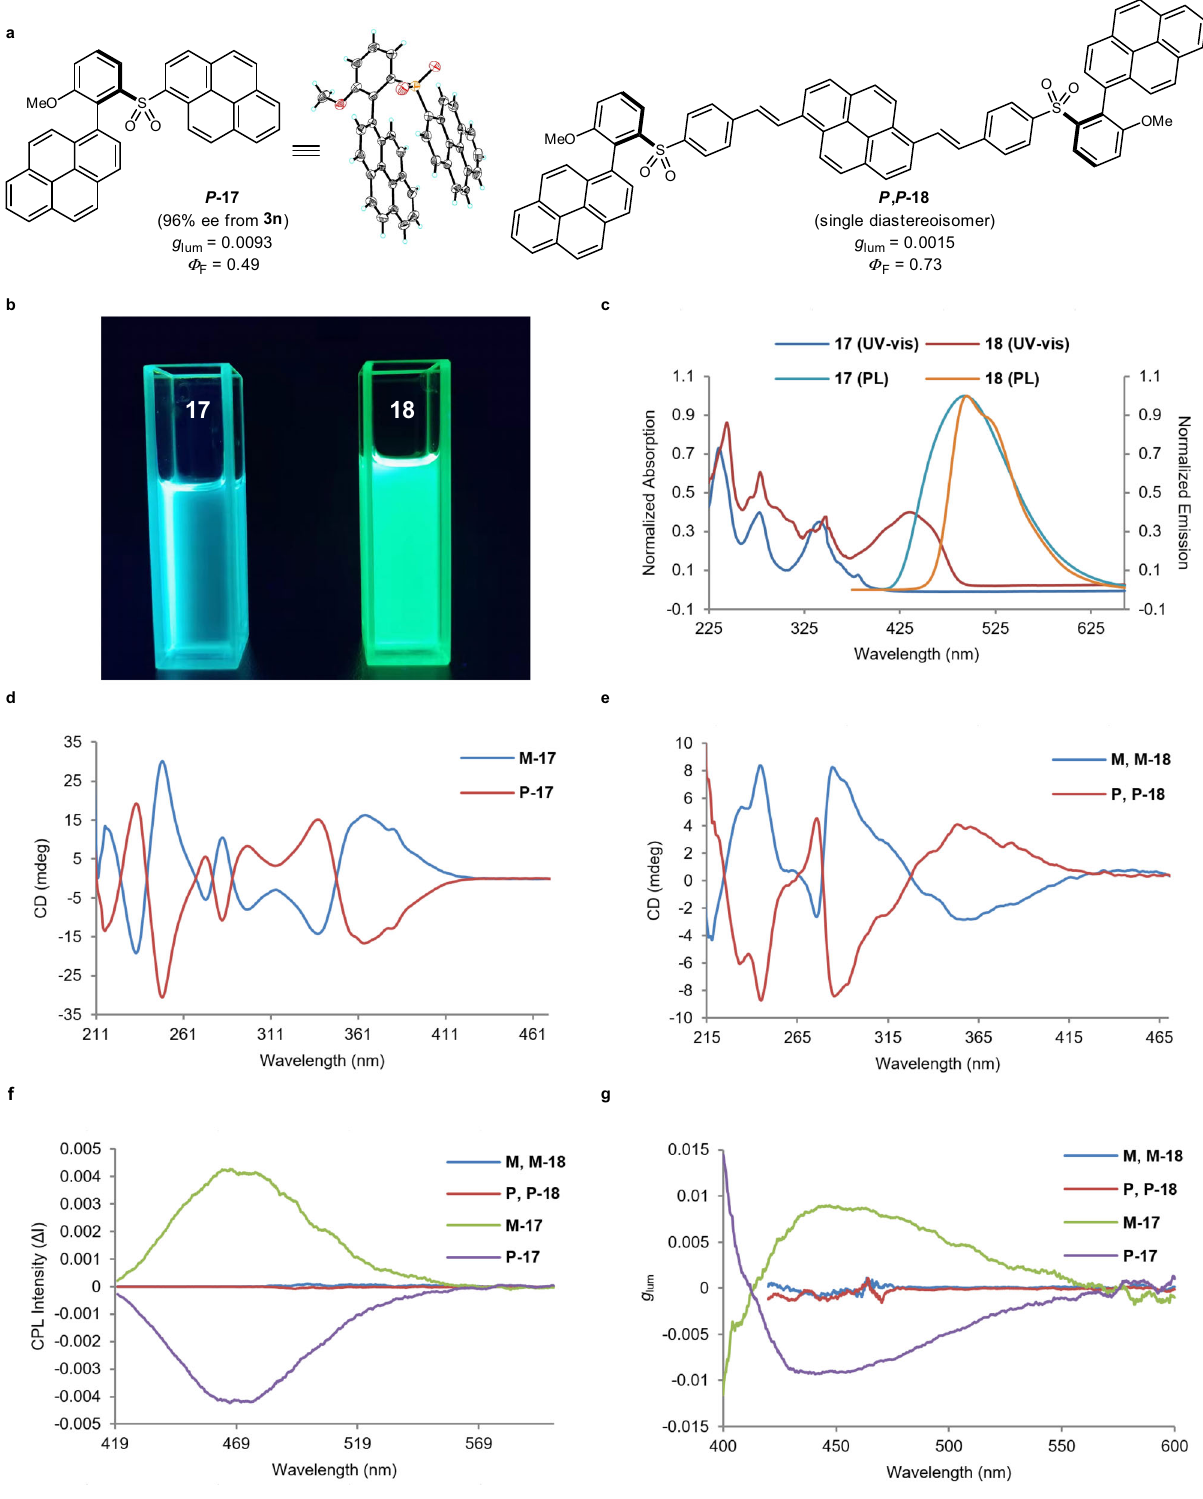
Fig. 7 | Photophysicalproperties of chiralcompounds 17 and 18.a Structures of 17 and 18 . b Fluorescenceimages of 17 and 18 inDCM ( λ ex =365nm). c Absorption and fl uorescence spectraof 17 and 18 in CH 2 Cl 2 (1.0×10 − 6 M), λ ex =363nm (for 17 ), λ ex =345nm (for 18 ). d CD spectra of M - 17 and P - 17 in CH 2 Cl 2 (1.0×10